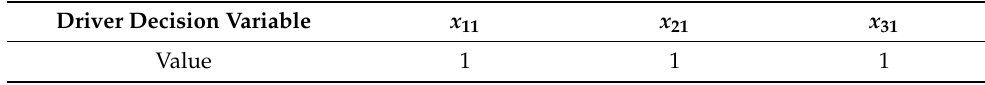
Table 9. Solution x for drivers when r D = r P =